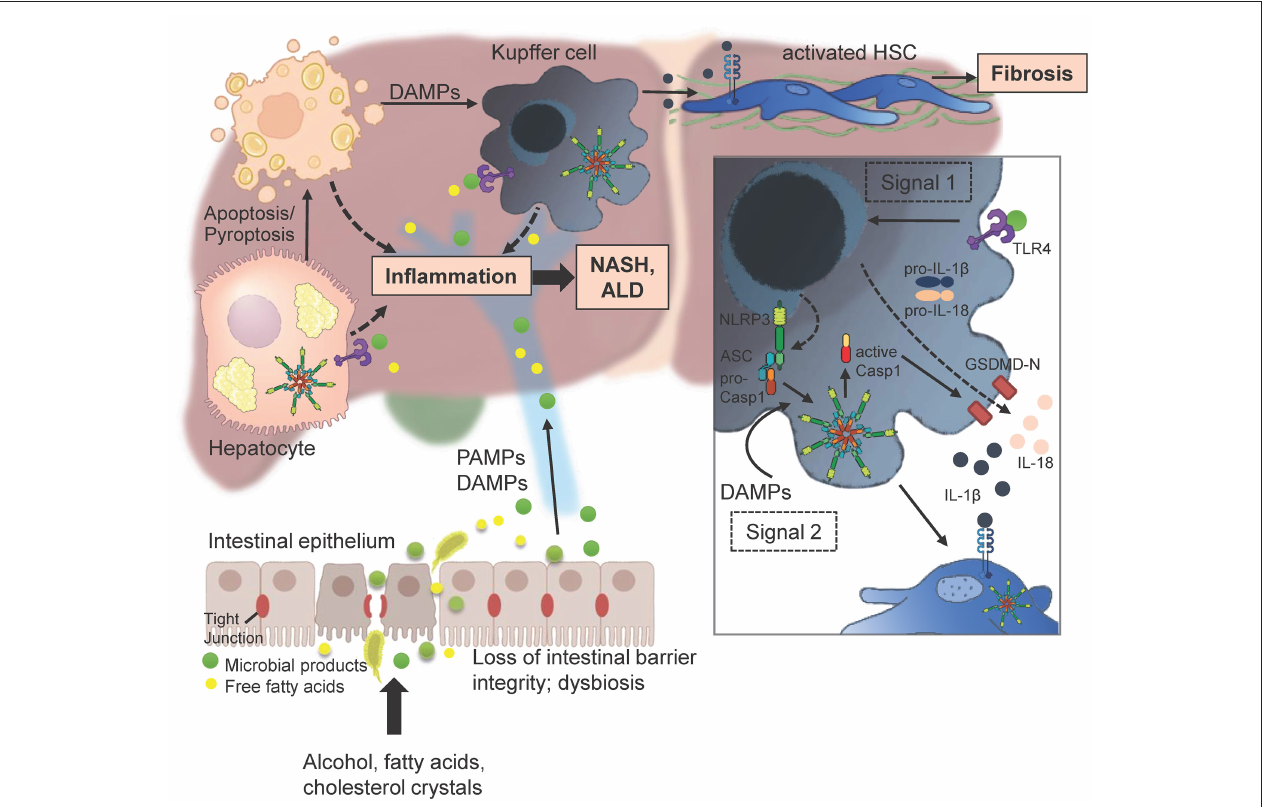
FIGURE 8 | Multitudes of metabolic products like alcohol and free fatty acids can lead to enhanced intestinal permeability by disrupting tight junctions of intestinal epithelial cells. PAMPs and DAMPs that enter the liver initiate gene transcription of pro-IL-1 β , pro-IL-18, and NLRP3 itself by binding to an appropriate receptor (here TLR4; signal 1). Injured and dying hepatocytes release DAMPs including endogenous ATP or uric acid that promote the assembly of the three main effectors NLRP3, ASC and procaspase 1 to form the inflammasome. The active caspase 1 cleaves pro-IL-1 β and pro-IL-18 as well as Gasdermin (GSDMD) into their mature forms. The N-terminal GSDMD fragments form a membrane pore to enable the release of IL-1 β and IL-18 in order to attract further immune cells (Figure was partly created by